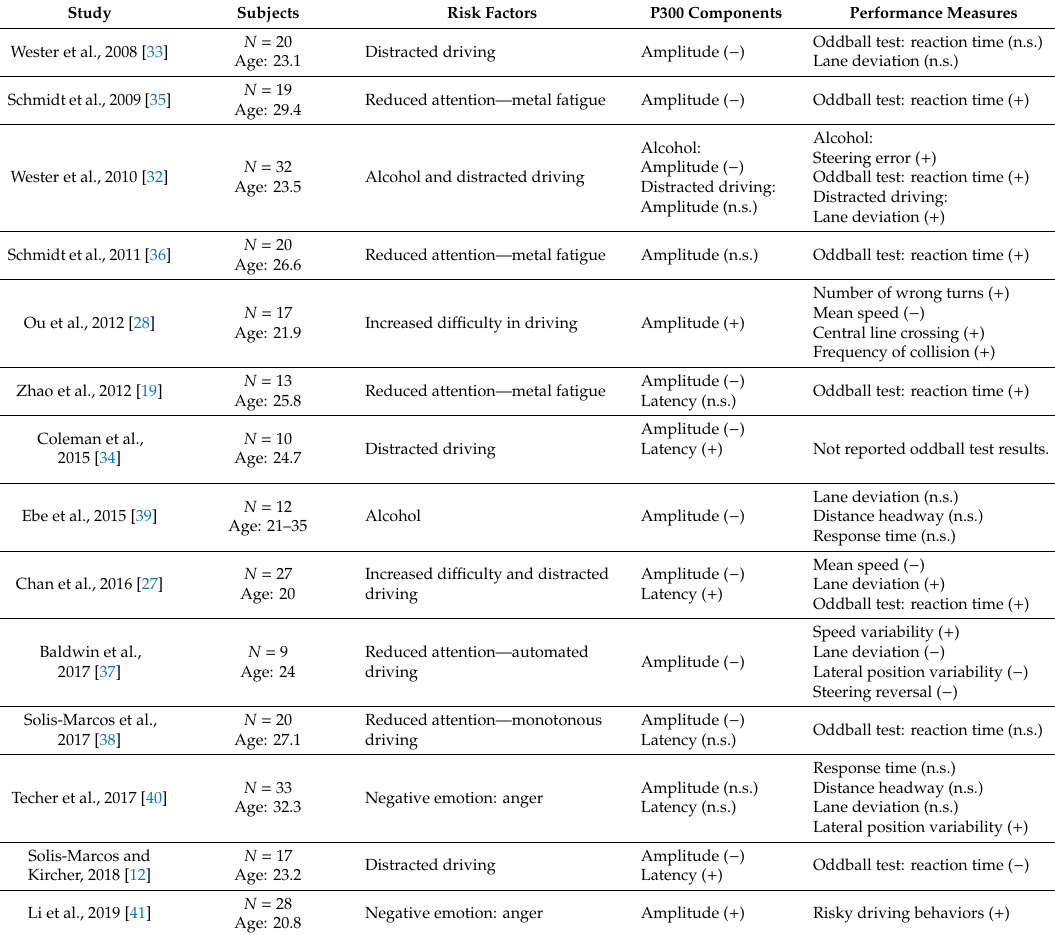
Table 1. Characteristics of the included